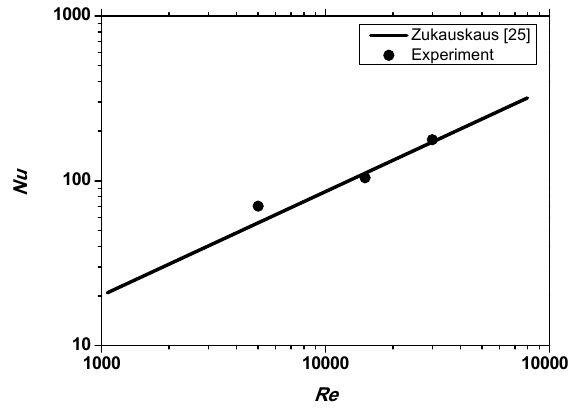
Figure 5. Comparison of experimental results.